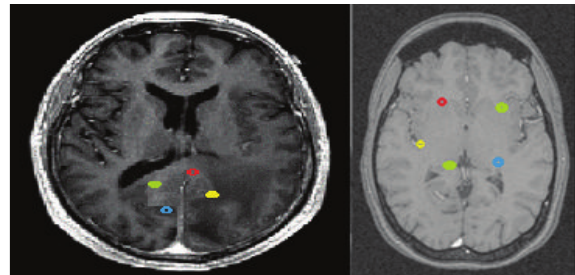
Figure 3: Expert level draw on each volume of interest (VOI).